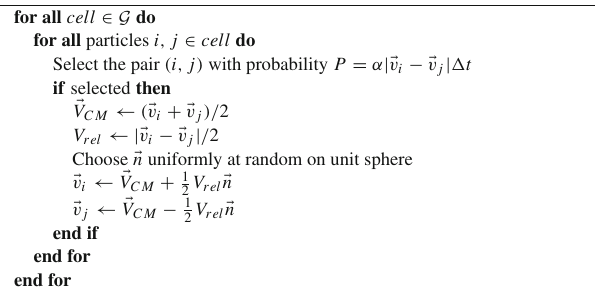
Algorithm 1 DM particle–particle scattering algorithm